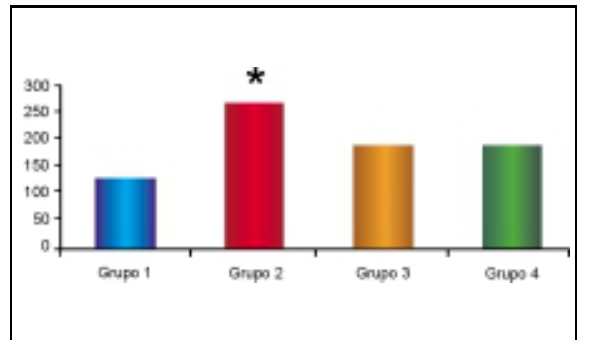
FIGURA 6 - Gráfico demonstrando os valores da Aspartato aminotransferase (U/L), (* = p < 0.05).